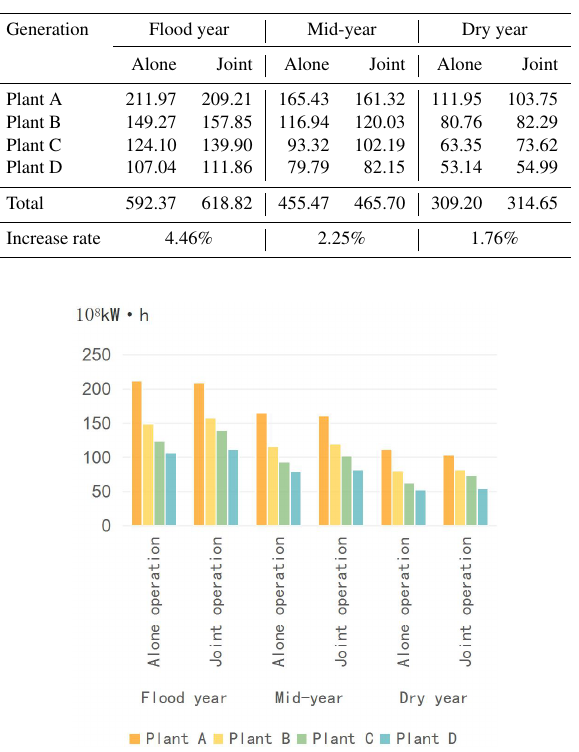
Table 1. Cascade power generation 10 8 kWh.